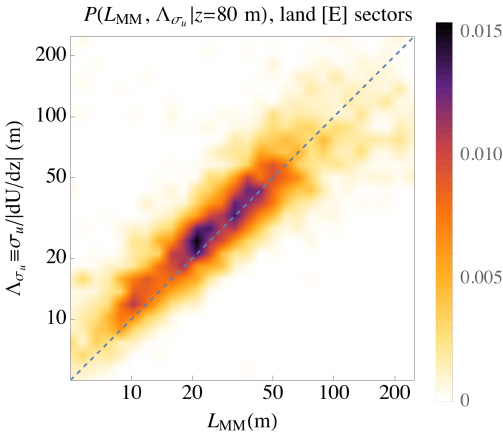
Figure 3. Joint probability density function of predicted and di- agnosed (observed) turbulent length scale, from measurements at Høvsøre over the homogeneous eastern land sectors. x axis: Mann- model scale L MM from spectral fits; y axis: L MM estimated from direct measurements of d U/ d z and σ u , via Eq. (15).